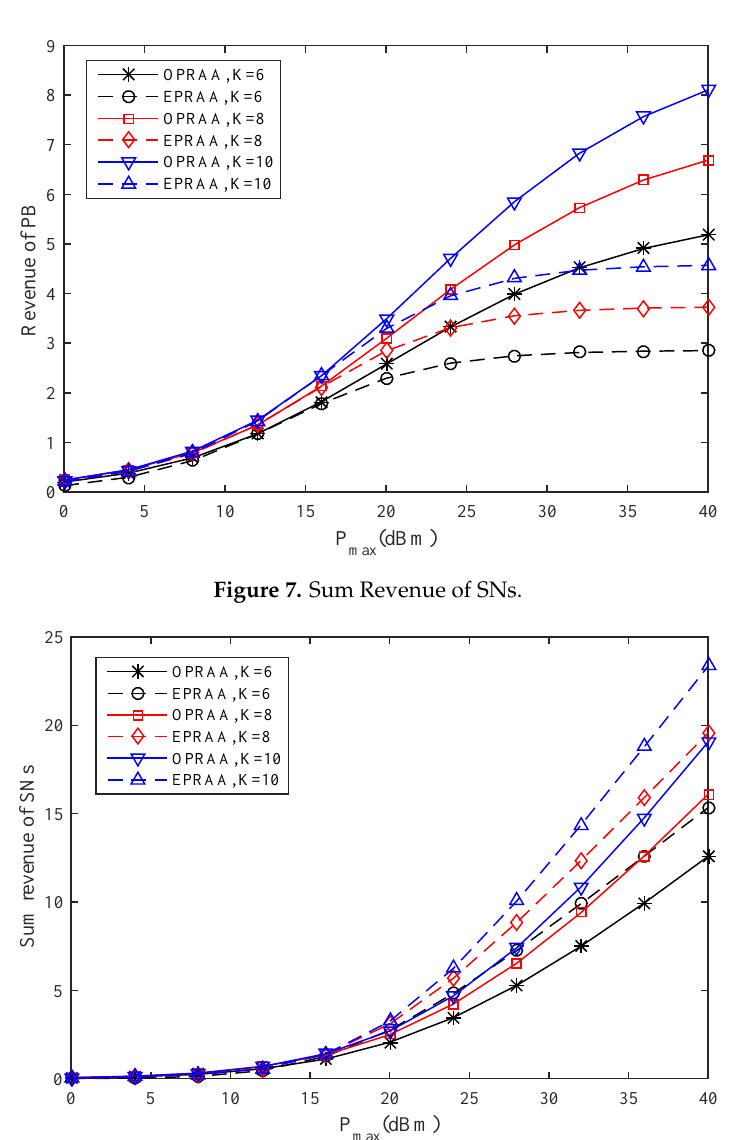
Figure 8. Sum Revenue of